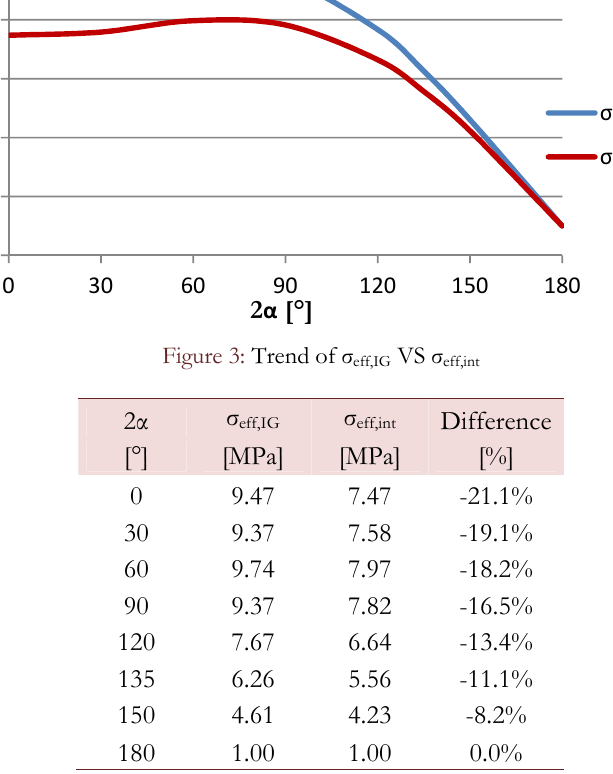
Table 1: Value of σ eff,IG and σ eff,int at any tested